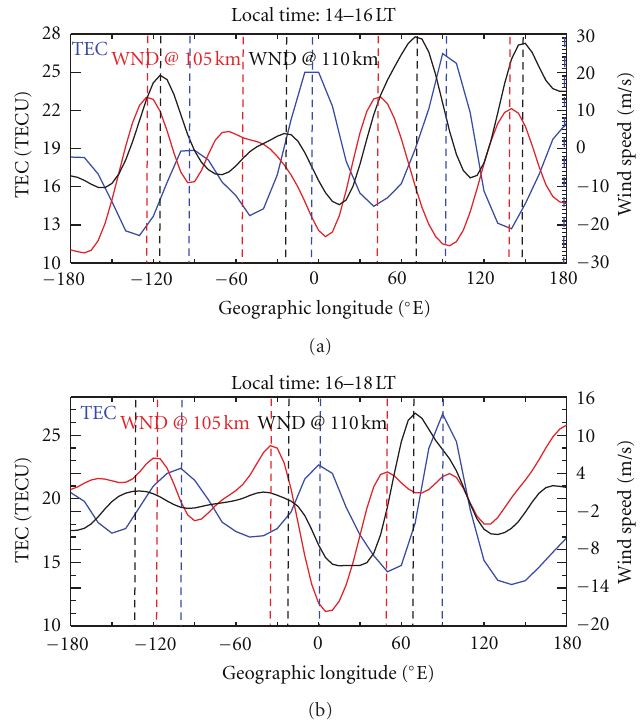
Figure 6: The peaks of the global TEC distributions (blue curve) along with the peaks of the zonal winds, measured by TIDI instrument onboard TIMED satellite at an altitude of 105km (red curve) and 110 km (black curve), as a function of longitude during 1400–1600 (top panel) and 1600–1800 (bottom panel) local